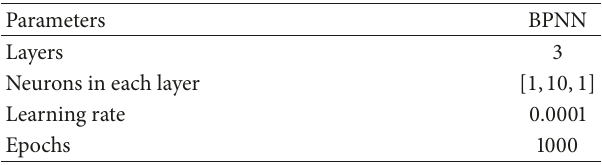
Table 2: Parameters of BPNN in